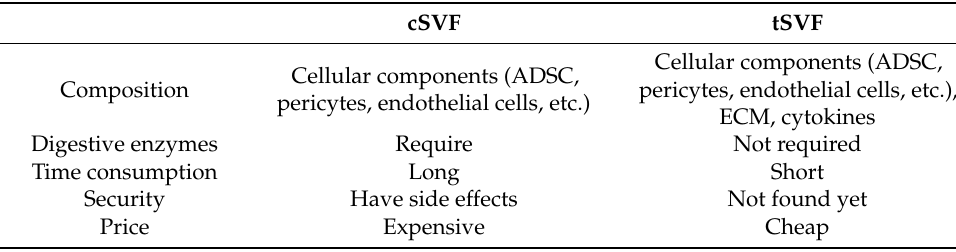
Table 1. Comparison of the advantages and disadvantages of cSVF and tSVF. cSVF Cellular components (ADSC, Composition pericytes, endothelial cells,